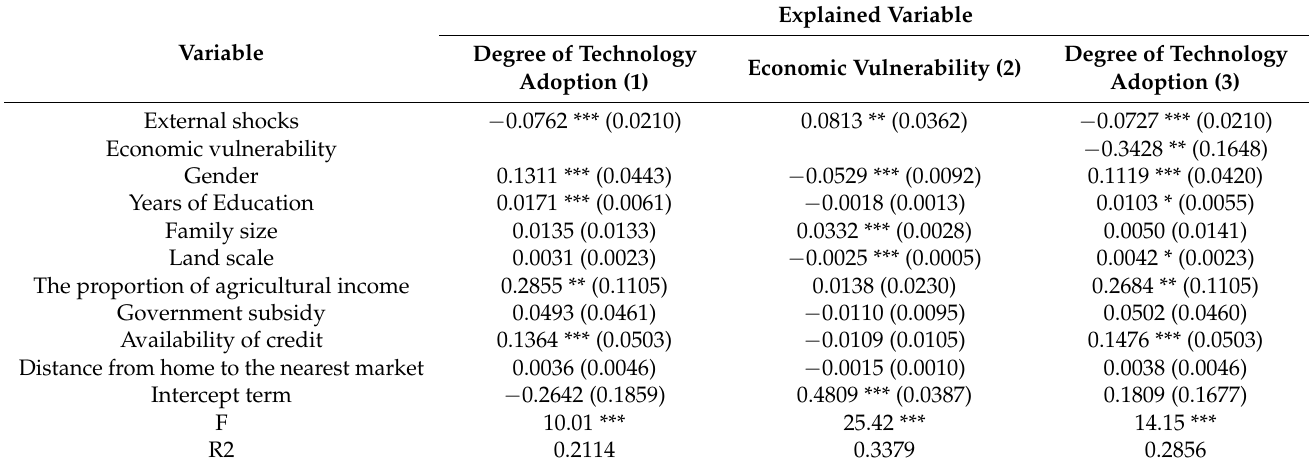
Table 1. Testing and estimation of the mediation effect of economic vulnerability.